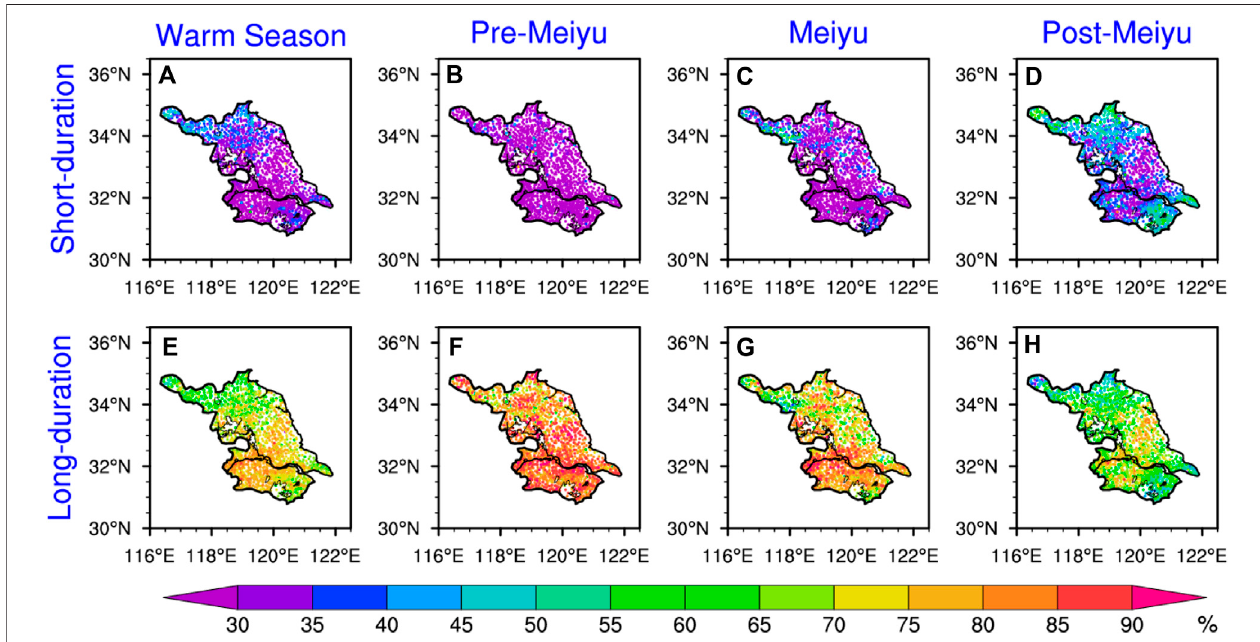
FIGURE 4 | Contribution of the short-duration rainfall (A-D) and long-duration rainfall (E-H) in warm season and each sub-period of warm season (four rows separately represent Warm season, Pre-Meiyu, Meiyu and Post-Meiyu period) over 2013 – 2017.